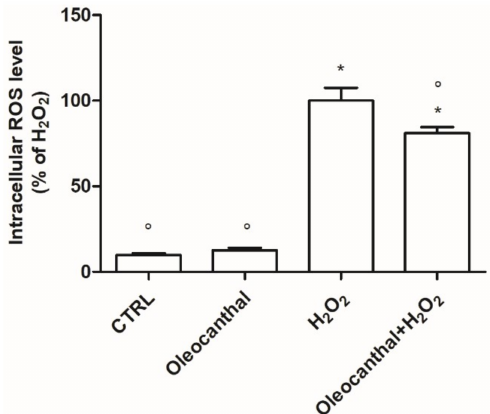
Figure 2. Antioxidant activity of oleocanthal against H 2 O 2 in differentiated SH-SY5Y cells. Cells were treated with 10 µ M oleocanthal and after 24 h were exposed to H 2 O 2 . Intracellular reactive oxygen species (ROS) levels were measured with the peroxide-sensitive probe DCFH-DA as reported in Materials and Methods. Data are expressed as a percentage with respect to H 2 O 2 -treated cells. Each bar represents mean ± SEM of at least four independent experiments. Data were analyzed by one-way ANOVA followed by Bonferroni’s test. * p < 0.05 with respect to CTRL; ◦ p < 0.05 with respect to H 2 O 2 .